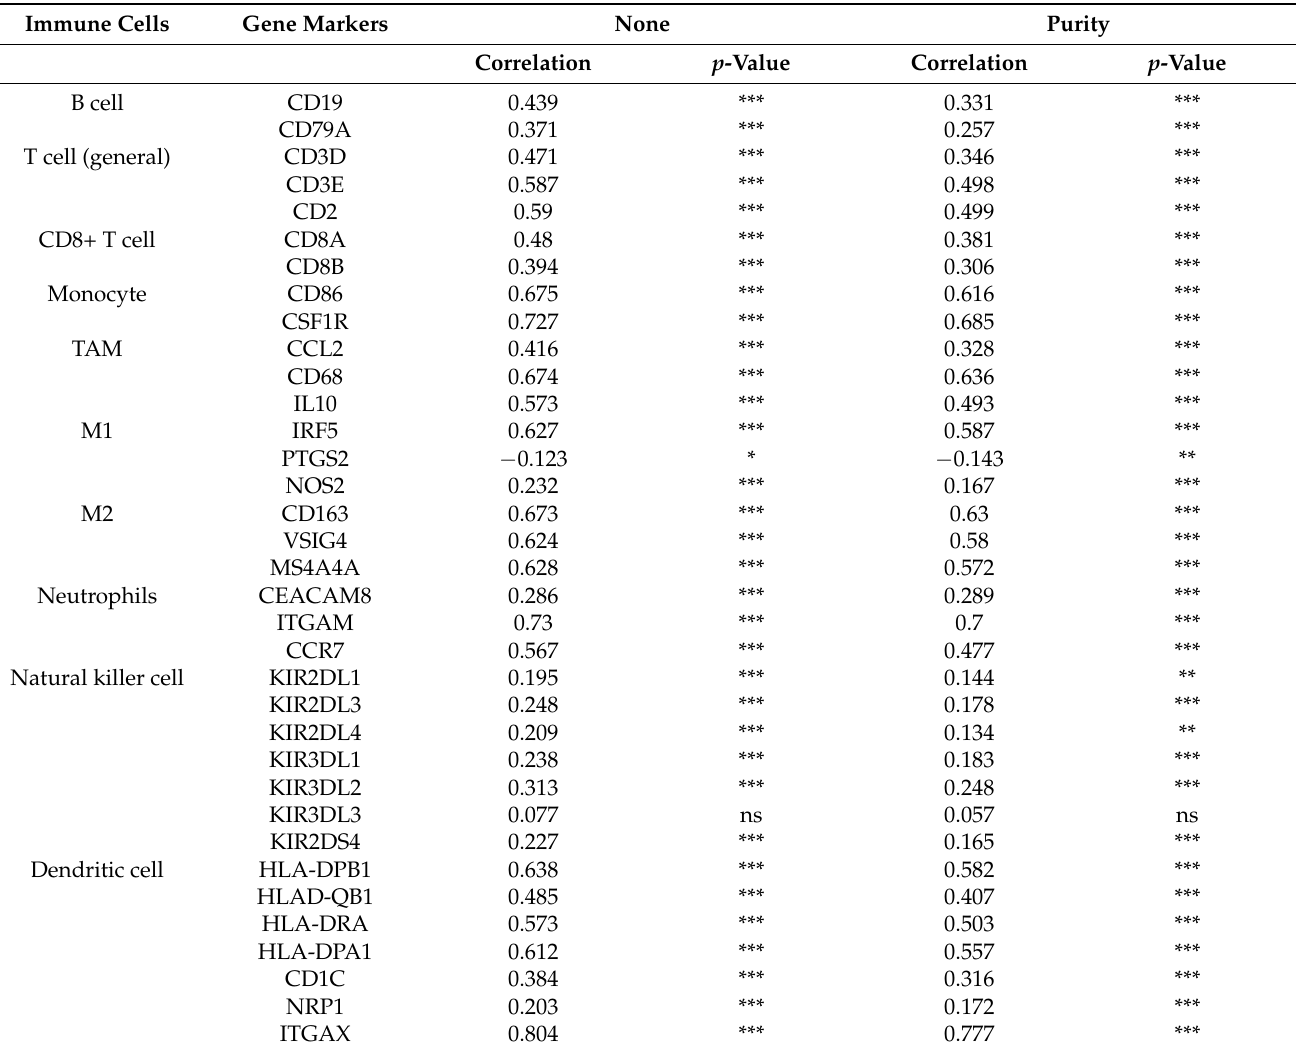
Table 3. Correlation analysis between KCNAB2 and gene markers of immune